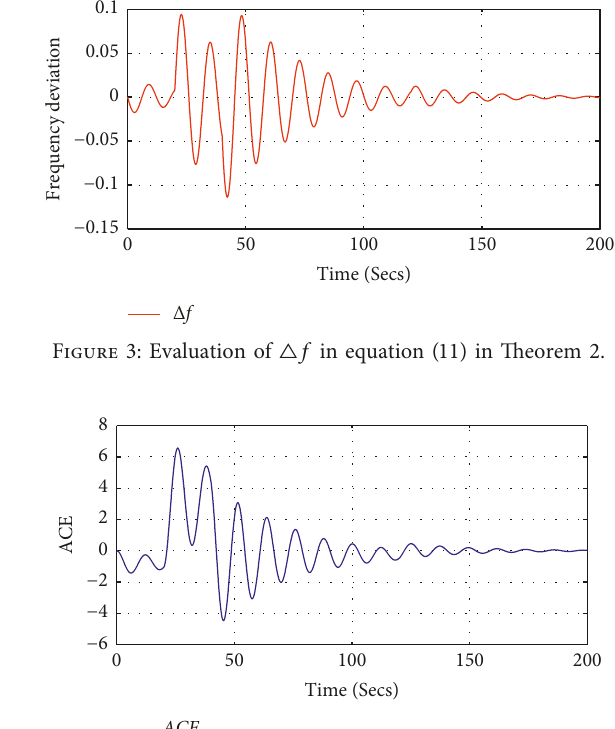
, d , η , σ , and ς in 1 2 0